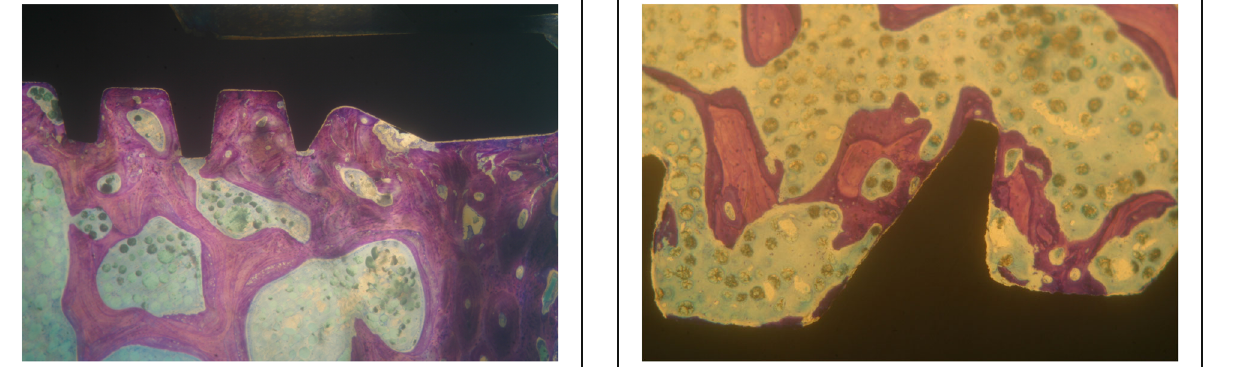
Figure 2 Test group. Implants in the test group showed an extremely high percentage of bone directly contacted to implant surface (magnification × 25 — toluidine blue)